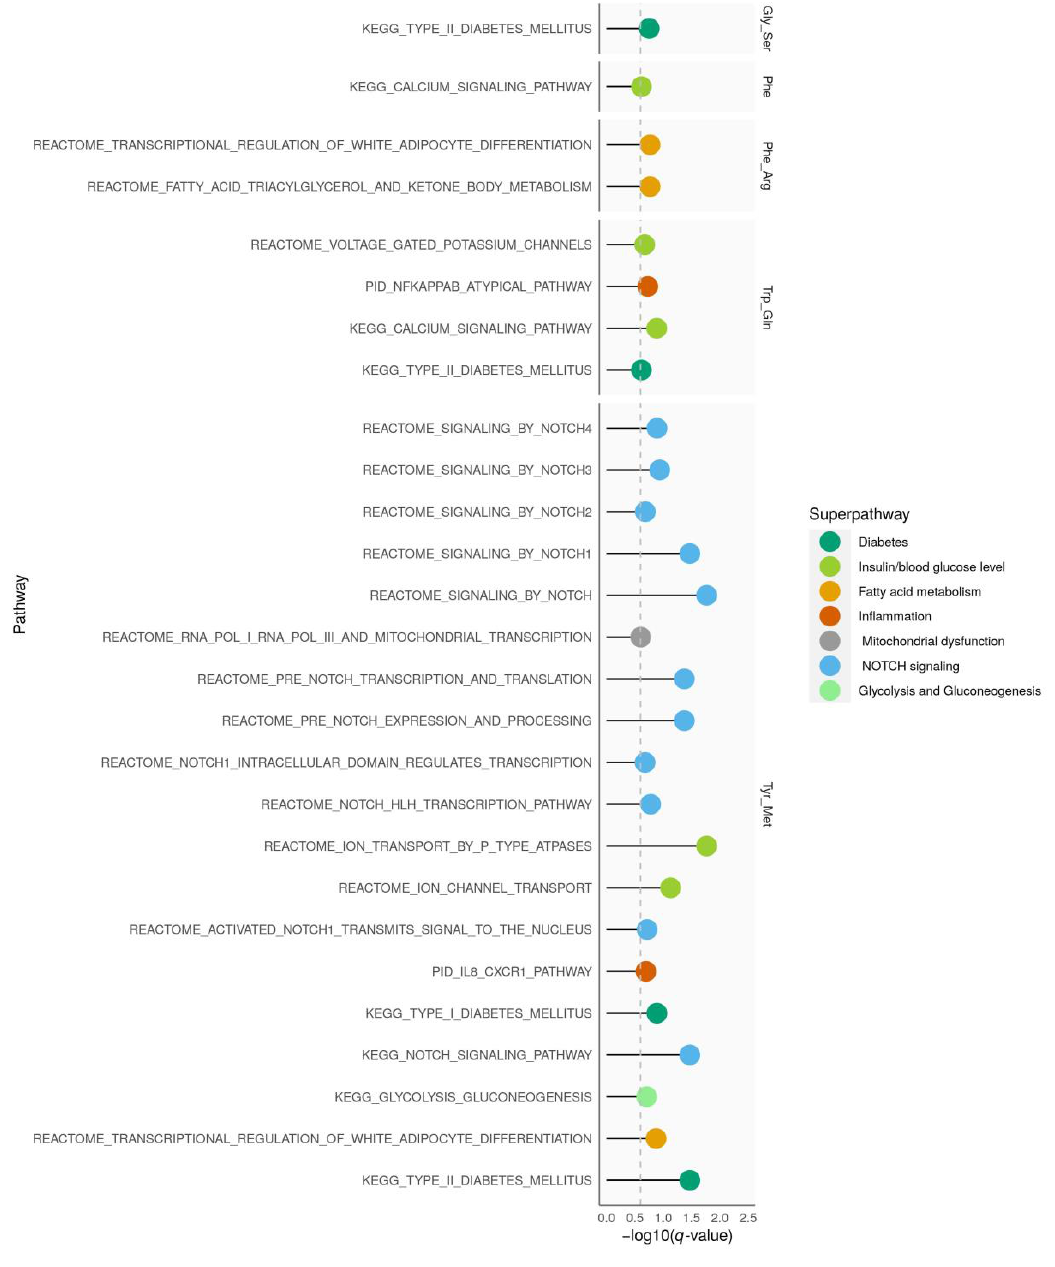
Figure 2. Pathway enrichment analysis. For each amino acid trait, pathways with significant enrichment of SNPs ( q -value < 0.25) that mapped to gold standard pathways for type 2 diabetes are shown. Arg, arginine; Gln, glutamine; Gly, glycine; Met, methionine; Ser, serine; Phe, phenylalanine; Trp, tryptophan, Tyr,